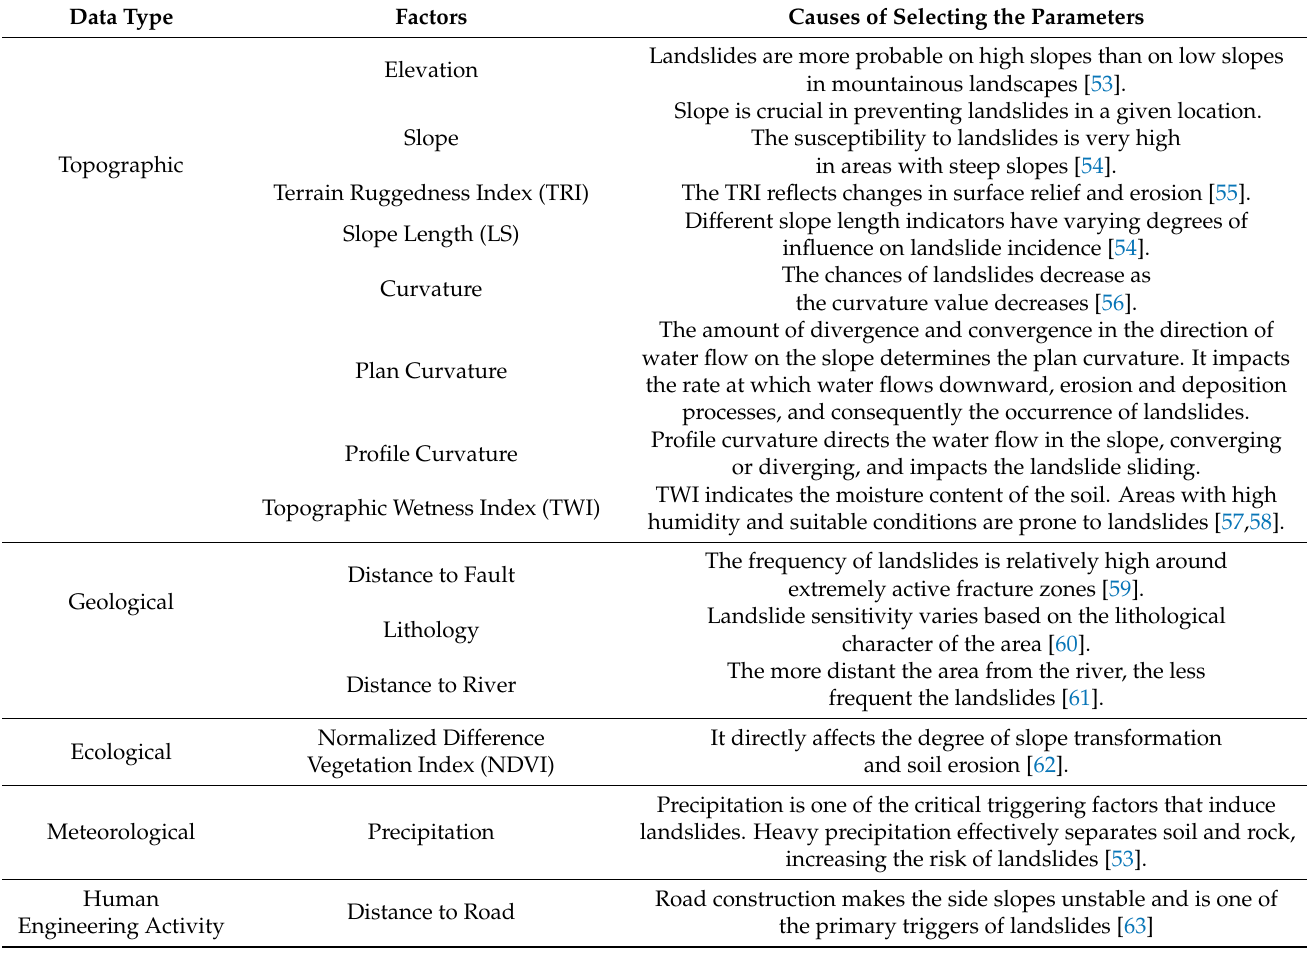
Table 1. Data source and causes of